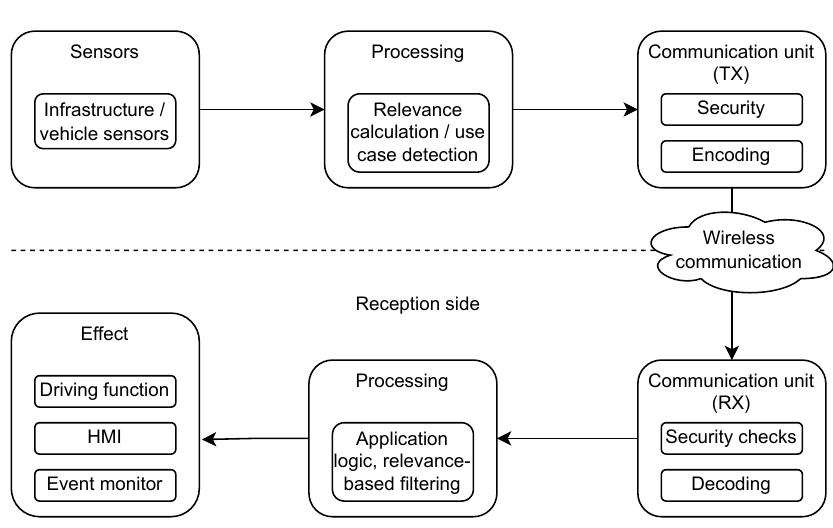
Figure 2. Generic V2X information